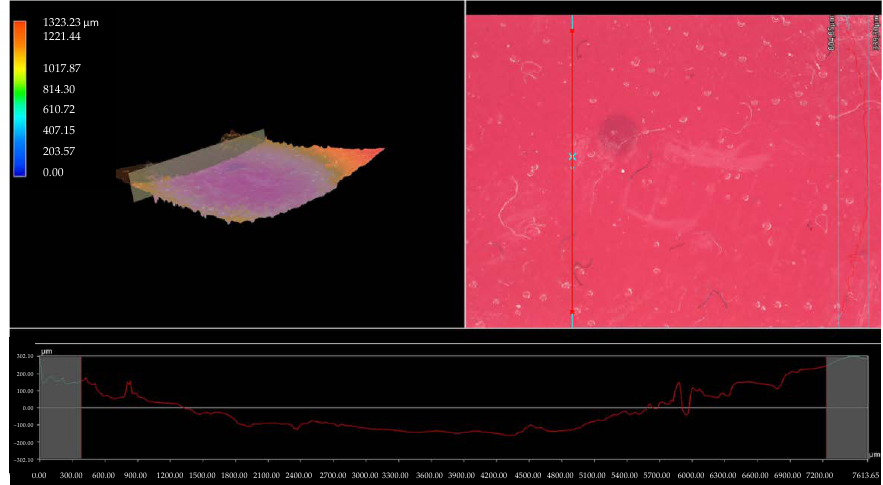
Figure 7. 3D view and the roughness profile (along the red line) of sample